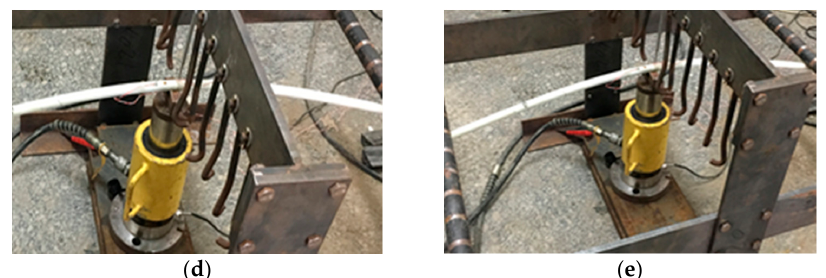
Figure 2. Short-term test fixture setup. ( a ) Diagram showing HFRP bars before bending; ( b ) Diagram showing HFRP bars on bending with an upstroke of jack shaft; ( c ) Location of strain gauges (t 1 and t 2 ), linear variable differential transducer (LVDT) (t 3 ), supports at both ends (L 1 and L 2 ), and applied load on mid-span (L); ( d ) and ( e ) photographs of the test setup.